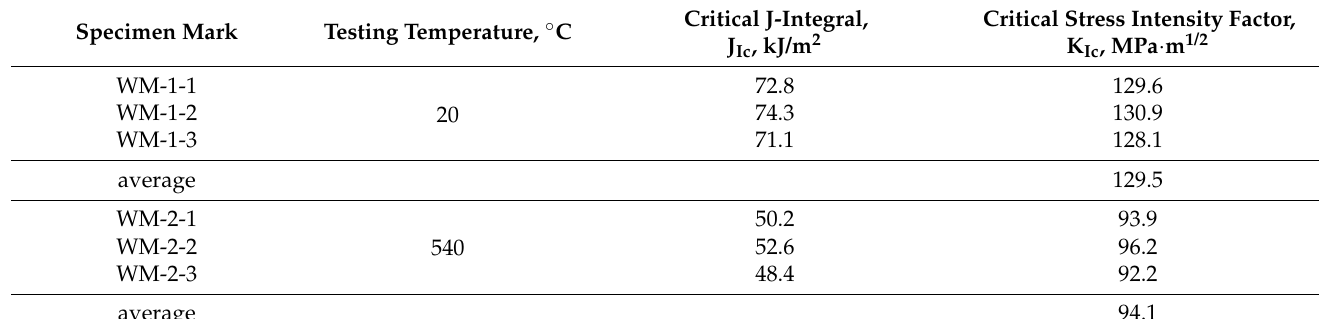
Table 14. Values of K Ic via J Ic for A387 Gr. B—WM.